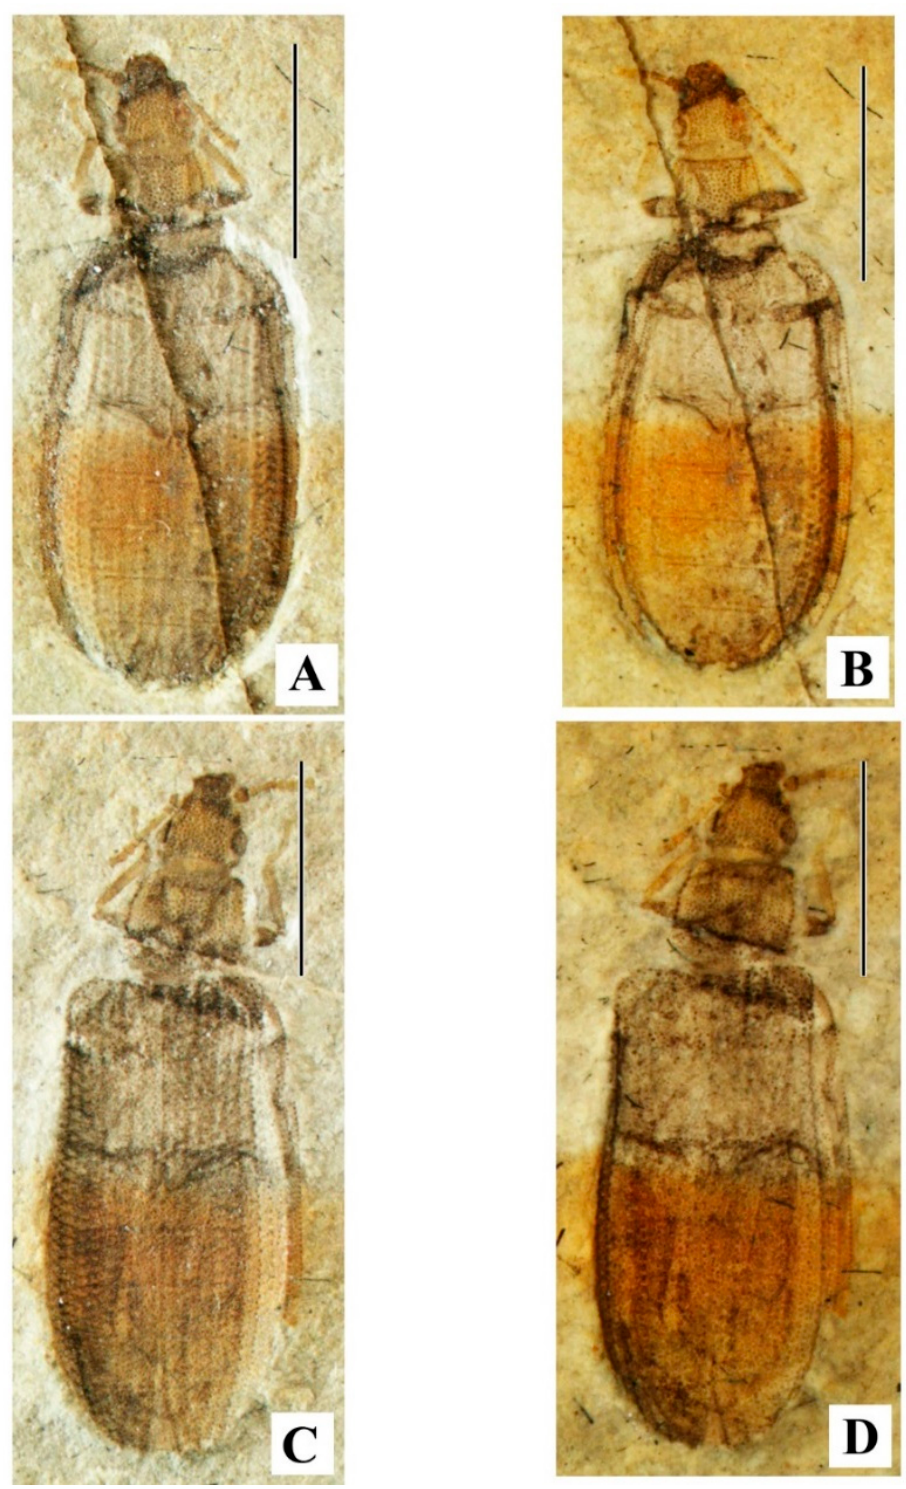
Figure 11. Ommatinae (Cupedidae): A - D — Monticupes curtinervis comb. nov. [ Tetraphalerus ], holotype CNU—C-LB2006006-1, part, CNU—C-LB2006006-2, counterpart (Lower Cretaceous, Lower Aptian Liaoning, Chaomidian): A —part, dry, B —same, wettened by alcohol; C —counterpart, dry and D —same, wettened by alcohol; length of print 11.5 mm, scale bar = 3.9 mm;